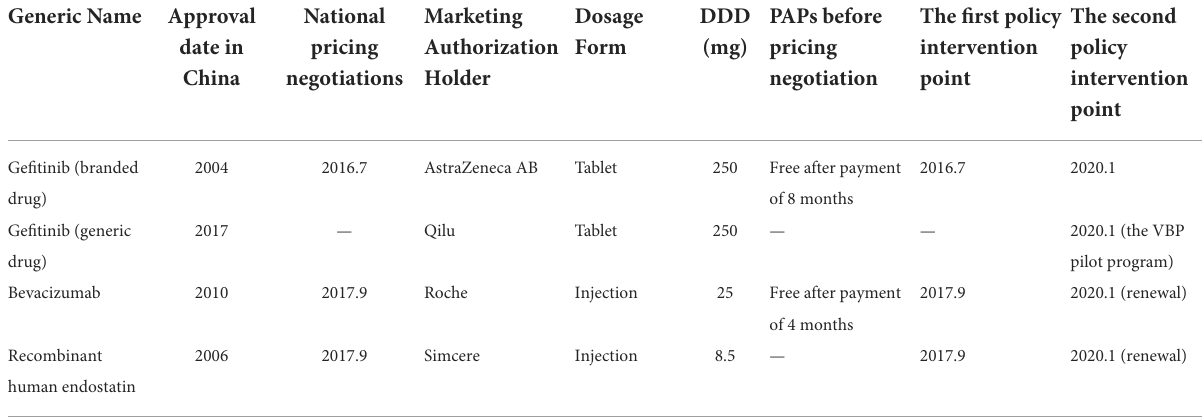
TABLE 1 Descriptive information and multiple interventions of gefitinib, bevacizumab, and recombinant human